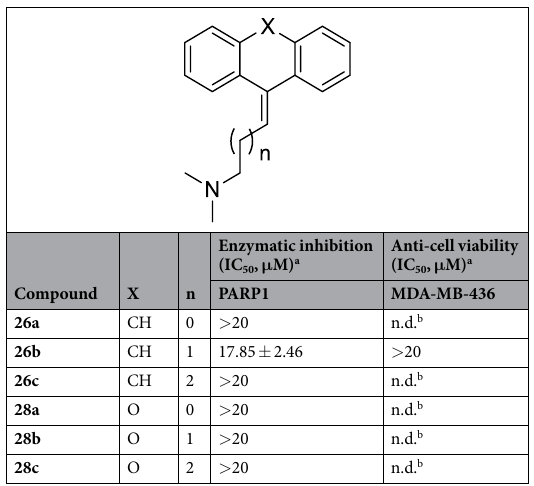
Table 5. Inhibition Data of compounds 26 and 28 against Recombinant Human PARP1 and MDA-MB-436 cells. a The IC 50 values are presented as mean ± SD, which is determined by at least three independent experiments. b The n.d. means data are not